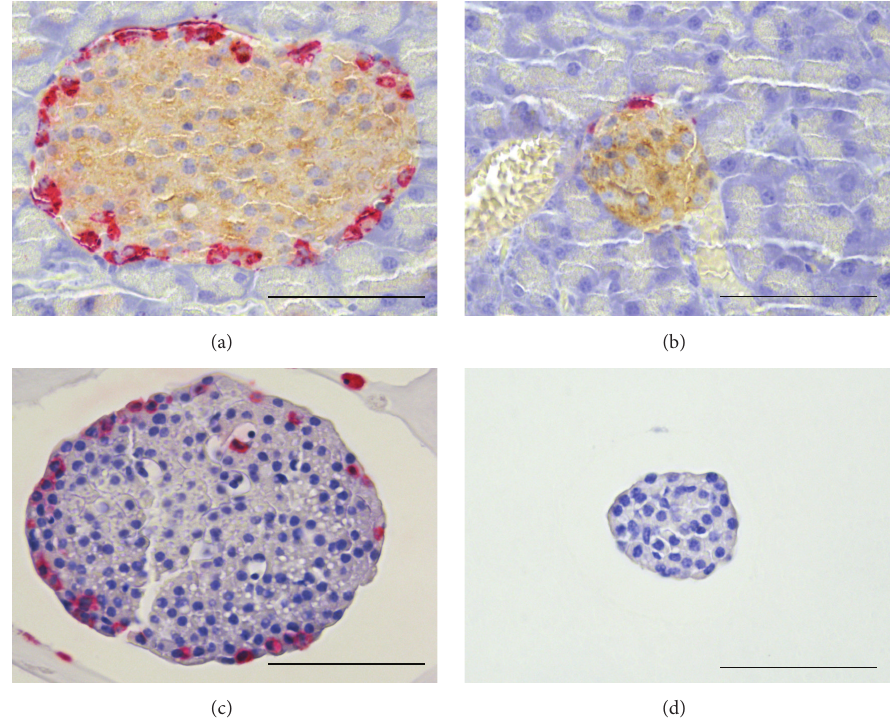
Figure 2: Double immunostaining of a big islet (a) and a small islet (b) in pancreas for glucagon (red) and insulin (brown). Immunostaining of an isolated big islet (c) and an isolated small islet (d) for glucagon (red). The isolated small islet (d) is devoid of glucagon-positive cells. Scale bars represent 50 𝜇